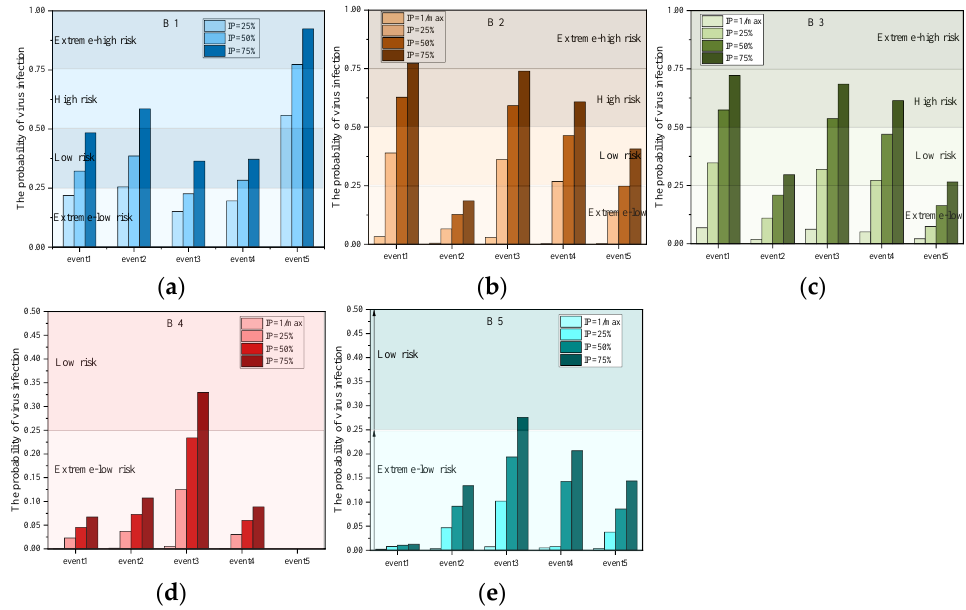
Figure 6. Change in virus infection with the proportion of infectious occupants without any measures. ( a ) Dormitory building, ( b ) Lecture building, ( c ) Office building, ( d ) Canteen building, ( e ) Library